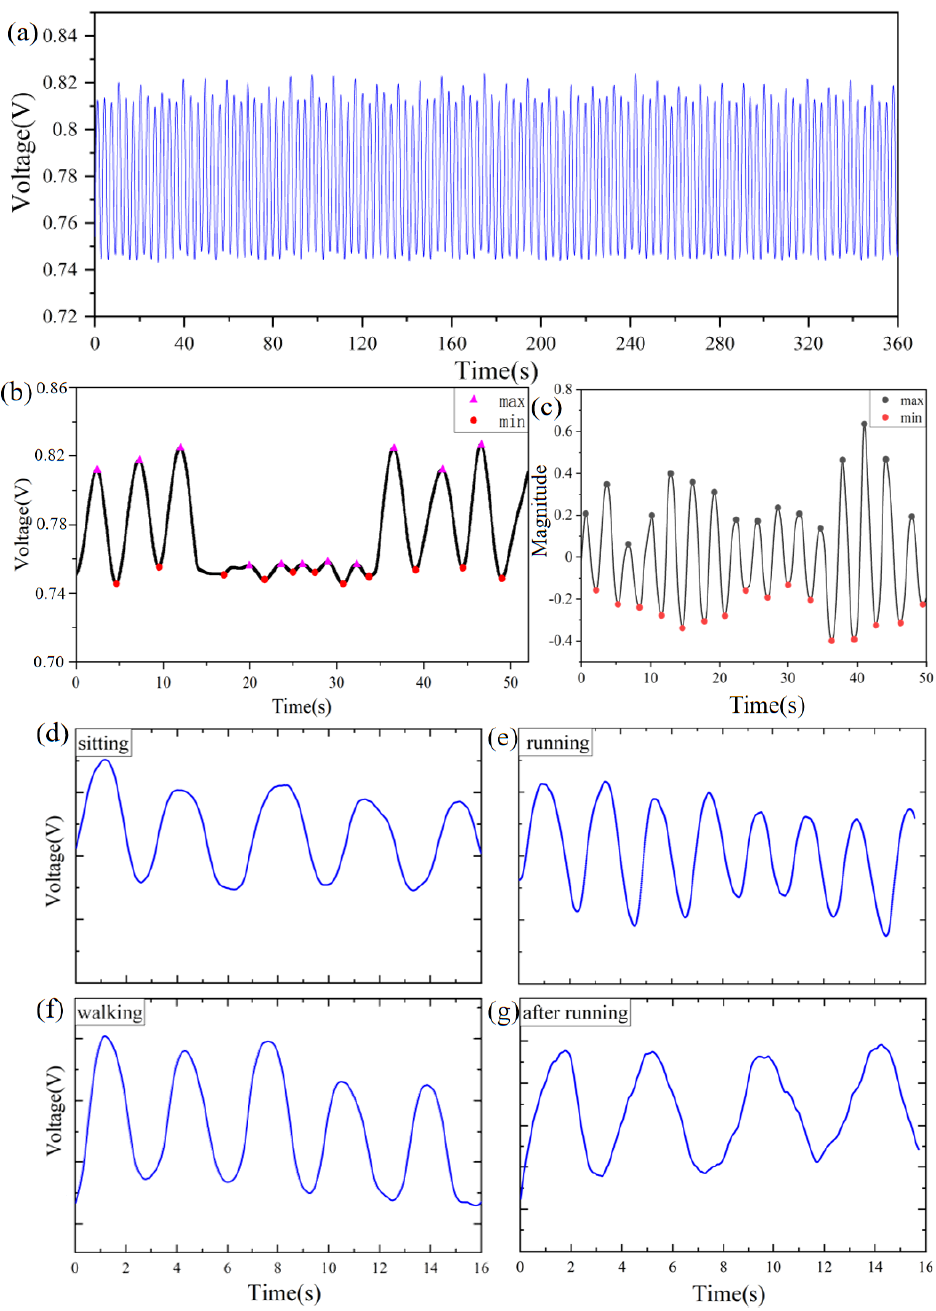
Figure 9. ( a ) Long − time measurement results (6 min). ( b ) Apnea respiration signal. ( c ) Hypopnea. The voltage changes of the sensor during different exercising. ( d ) Sitting. ( e ) Walking. ( f ) Running. ( g ) After running.